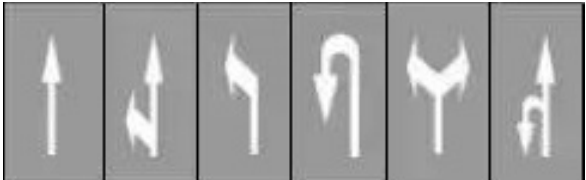
Figure 4. Template of arrow road markings for model matching